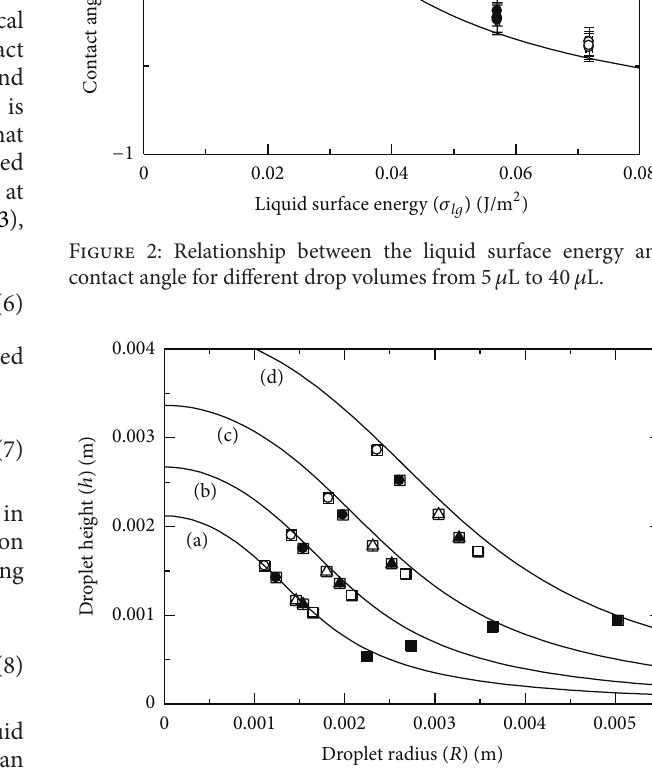
Figure 3: Relationship between droplet radius and height. The solid lines are (a) 5, (b) 10, (c) 20, and (d) 40 𝜇 L, respectively. The white circles, black circles, white triangles, black triangles, white squares, and black squares are experimental data of 0.071, 0.0570, 0.0384, 0.0312, 0.0274, and 0.0211J m −2 ,